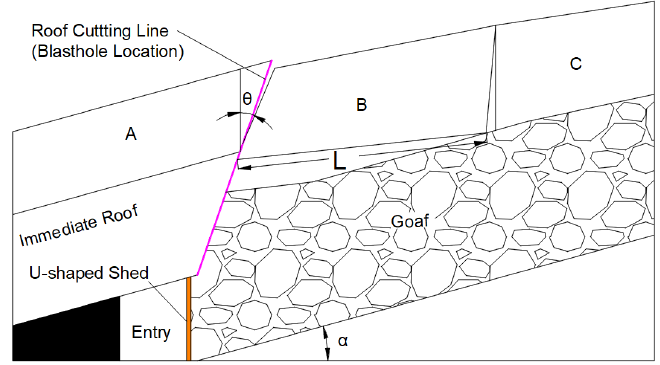
Figure 6. Roof structure of gob-side entry retaining by roof cutting (GERRC).